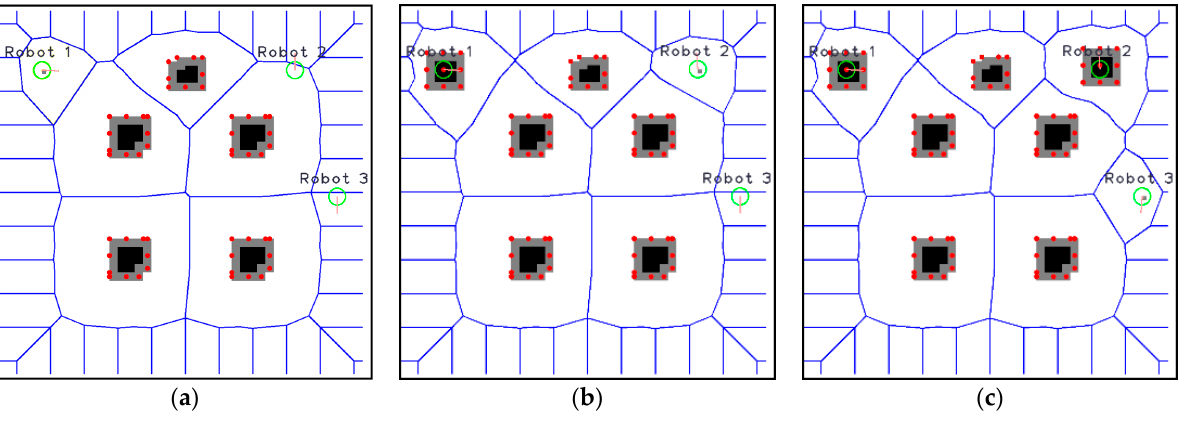
Figure 4. ( a ) The map of robot-1, ( b ) the map of robot-2, and ( c ) The map of